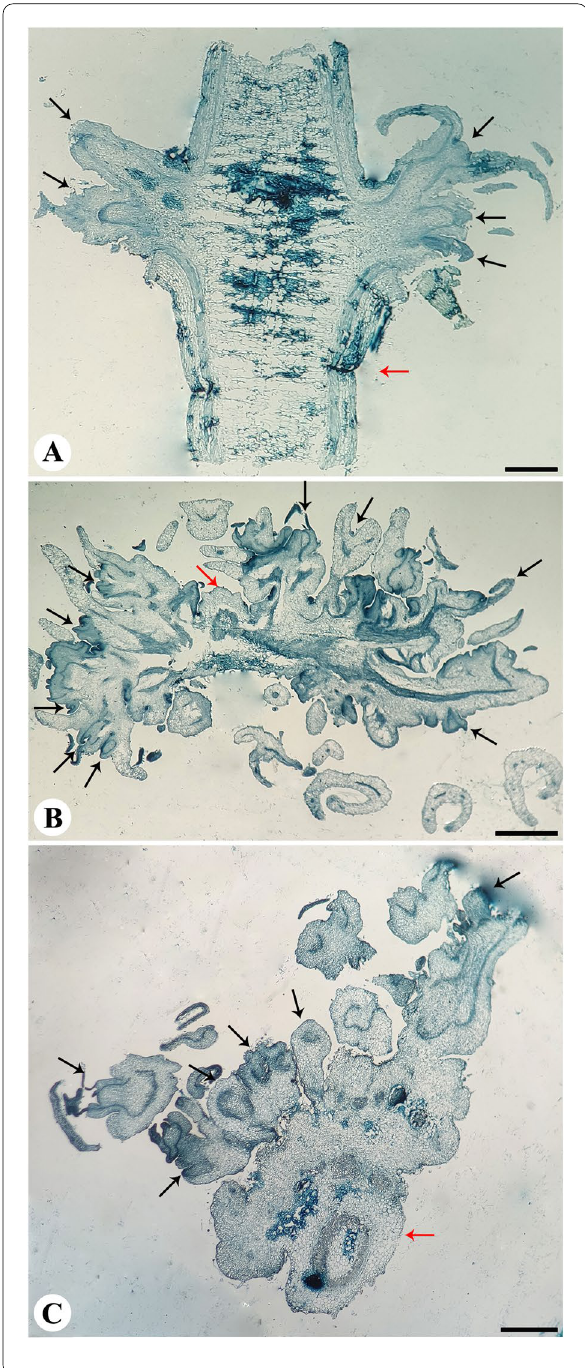
Fig. 2 Histological studies on shoot regeneration from varied explants of Andrographis producta . A Longitudinal section of the nodal explant developed on MS medium with 10 μM 2-iP after 2 weeks of culture showing direct shoot regeneration (bar-, 0.075 cm). B Section through 4-week-old shoot tip cultured on MS medium containing 5 μM BAP showing multiple shoot regeneration (bar-, 0.112 cm). C Transverse section of 4-weeks-old shoot tip explant cultured on 10 μM 2-iP showing direct shoot induction (bar-, 0.075 cm) (Black- colored arrows indicate newly formed shoot buds and shoot, and red arrows indicate original